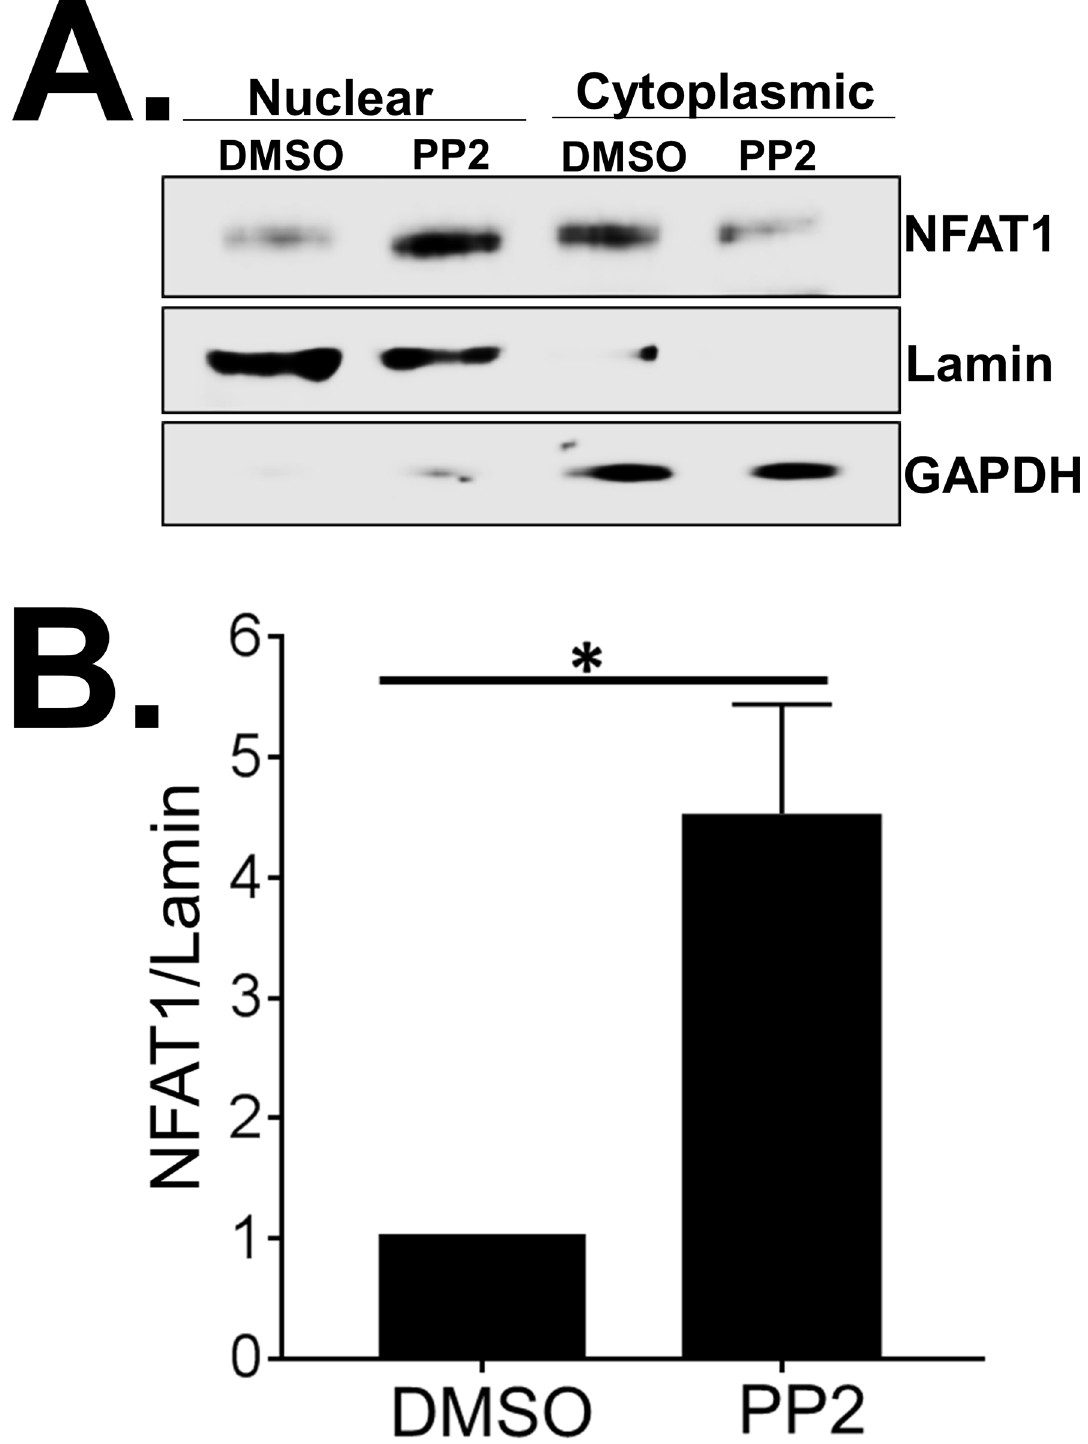
Fig 5. Active Src-family kinases (SFKs) prevent aberrantNFAT1 nuclear translocation in resting primary human T cells. (A) Immunoblot analysisof subcellular localizationof NFAT1, GAPDH and Lamin in primary human T cells treated with DMSO or PP2. GAPDH and Lamin served as a loadingcontrol for cytoplasmic and nuclear fractions respectively. (B) Quantification of the NFAT1 protein in the nuclear fraction of primary humanT cells obtained from four healthyblood donors either treated with DMSO or PP2. Amount of NFAT1 protein in the nuclear fraction was normalizedby the Lamin protein. Each experiment was independently performed with four different donors with consistent results. * P < 0.01. https://doi.org/10.1371/journal.pone.0187123.g005 PLOS ONE | https://doi.org/10.1371/journal.pone.0187123 October 26,